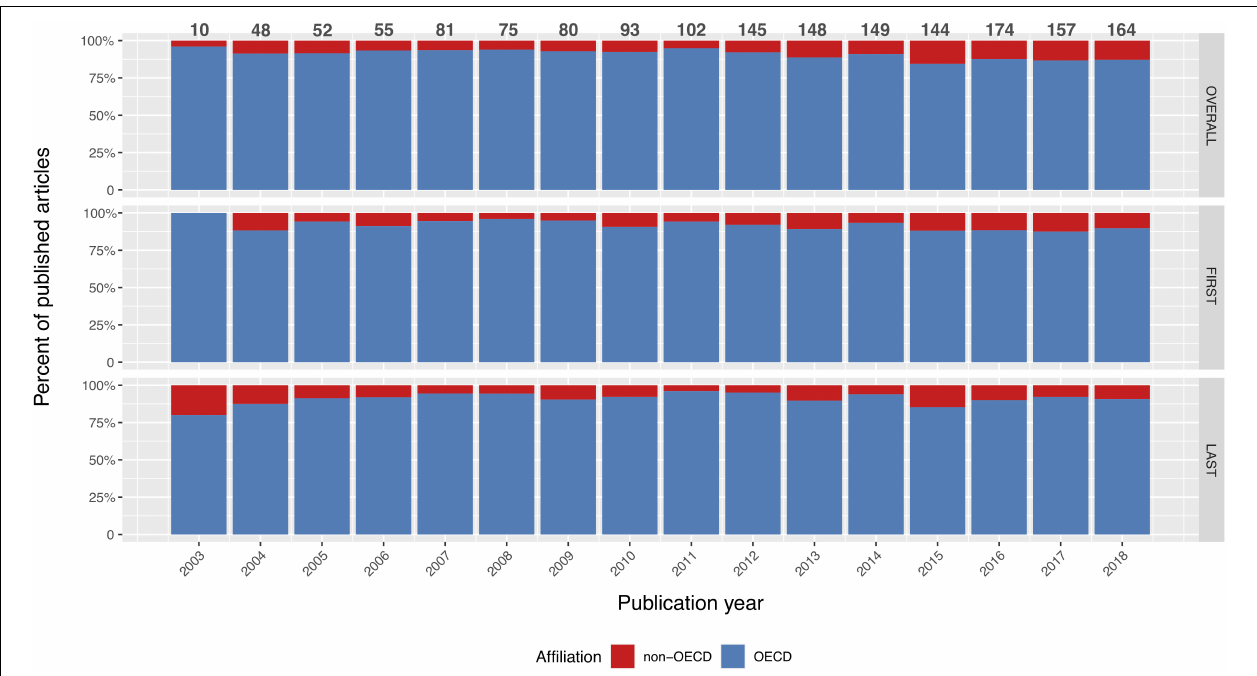
FIGURE 1 | Change in overall individual contribution of authors affiliated with institutions in non-OECD vs. OECD nations. Published articles over time (top panel) disaggregated by first (middle panel) and last author (bottom panel) position for articles with more than one author. For authors with more than one institutional affiliation, their non-OECD affiliation is used in this analysis. Numbers at the top of each bar indicate the total number of articles published that